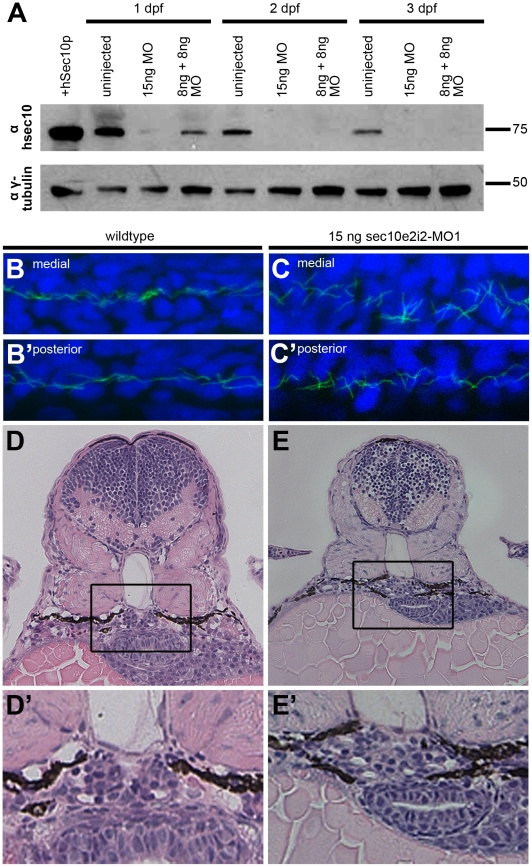
sec10MO embryos show abnormal pronephric development.(A) Immunoblots showing the 1-3 dpf time course of zfSec10 knockdown in
sec10MO embryos. sec10MO injections can lead to abnormal-appearing
embryos (Table 1),
but in this blot, 3 dpf sec10MO embryo lysates were isolated only from
embryos without any obvious morphological defects. This demonstrates
that these embryos still have strong knockdown of the zfSec10 protein.
Lysates from abnormal-appearing embryos showed similar levels of zfSec10
knockdown (data not shown). 5 embryos loaded per lane. Positive control
for Sec10 was from human Sec10 (hSec10) overexpressing MDCK cell
lysates. Blot was probed with antibodies against hSec10, and
gamma-tubulin as a loading control. (B-C′) Immunofluorescence with
antibody against acetylated-tubulin (green), and the nuclear Hoechst
stain (blue). Flattened Z-series from confocal imaging of medial (B,C)
and posterior kidney (B′,C′), 24 hours post fertilization
(hpf), lateral view, 80x magnification. Pronephric cilia length is
similar between uninjected embryos (B/B′) and 15ng sec10MO embryos
(C/C′); however, cilia within the medial pronephros are disordered
(compare B and C). (D-E′) JB-4 resin section (with enlarged inset)
of glomerular region, stained with Hematoxylin and Eosin, 3 dpf,
transverse 4 μm section, 40x magnification. Wild-type embryos show
an organized U-shaped glomerulus (D/D′), while 15ng sec10MO
embryos show disorganization (E/E′).